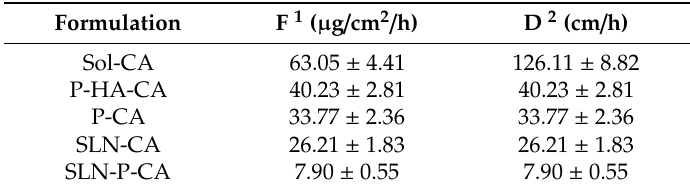
Table 6. Fluxes and diffusion coefficients of the indicated formulations.